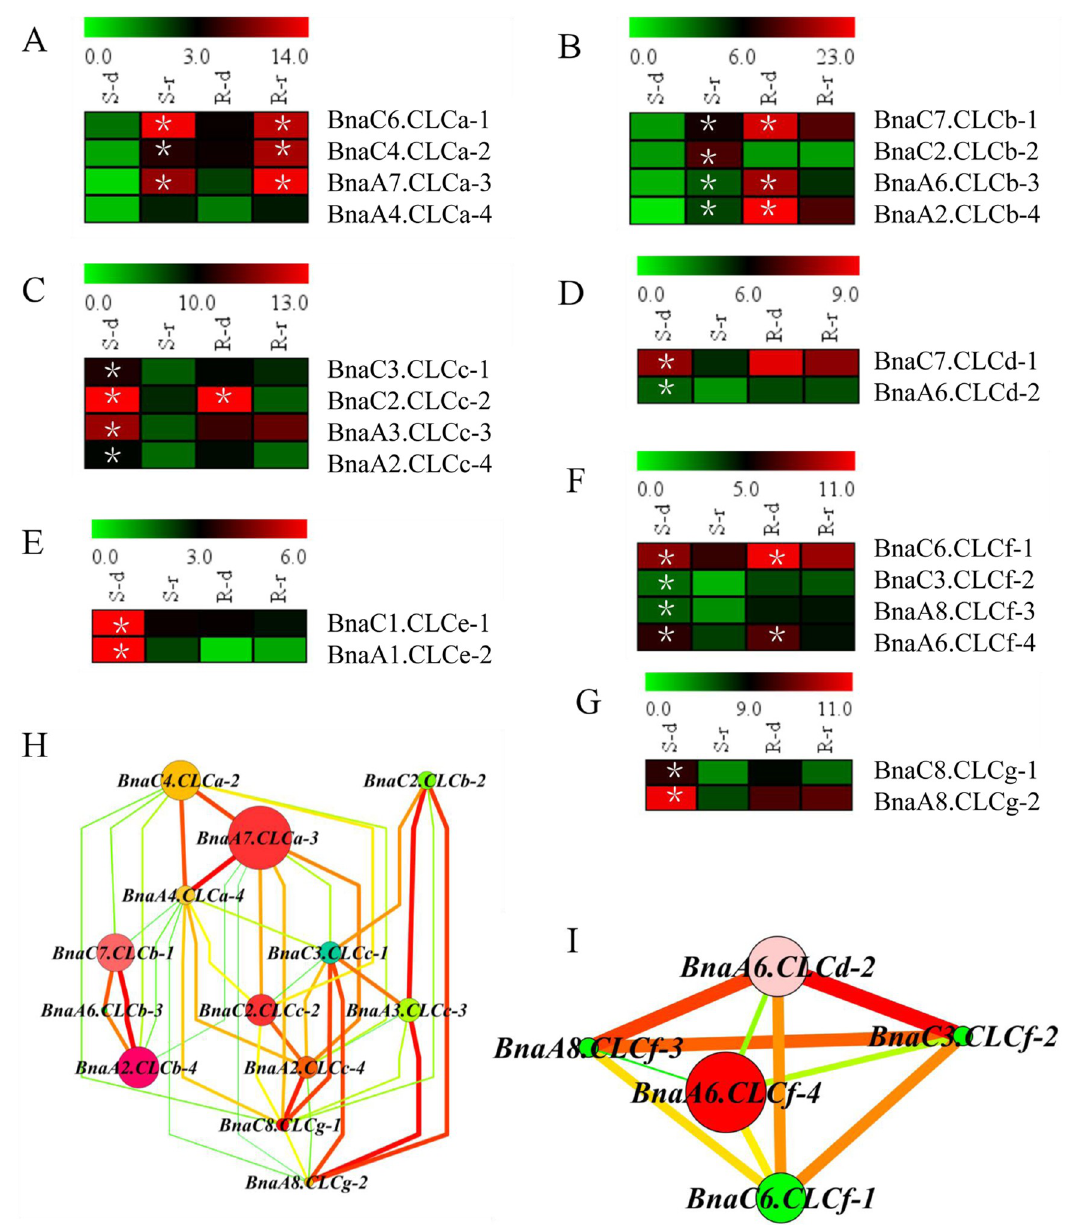
Fig 7. Expression profiling of the BnaCLCs in response to NO 3- depletion and resupply in B . napus (A-G). The shoots (S) and roots (R) were sampled separately for RNA seq. S-d shows shoot sample under NO 3- -depletion treatment, and S-r indicates shoot sample under NO 3- -resupply treatment. R-d represents root sample under NO 3- -depletion treatment, and R-r indicates root sample under NO 3- -resupply treatment. The asterisks denote significant differences at P < 0.05. Co-expression network analysis of the BnaCLCs (H, I). Cycle nodes represent genes, and the size of the nodes represents the power of the interaction among the nodes by degree value. Edges between two nodes represent interactions between